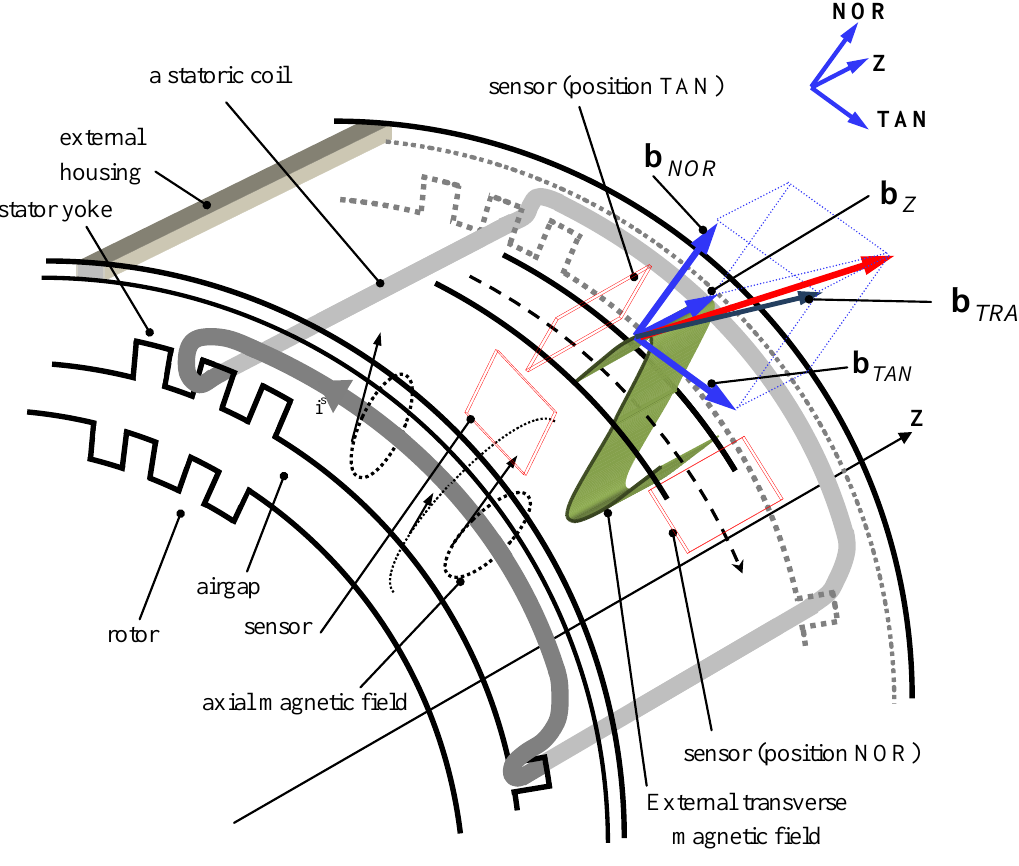
Figure 1. External magnetic field emitted by an AC